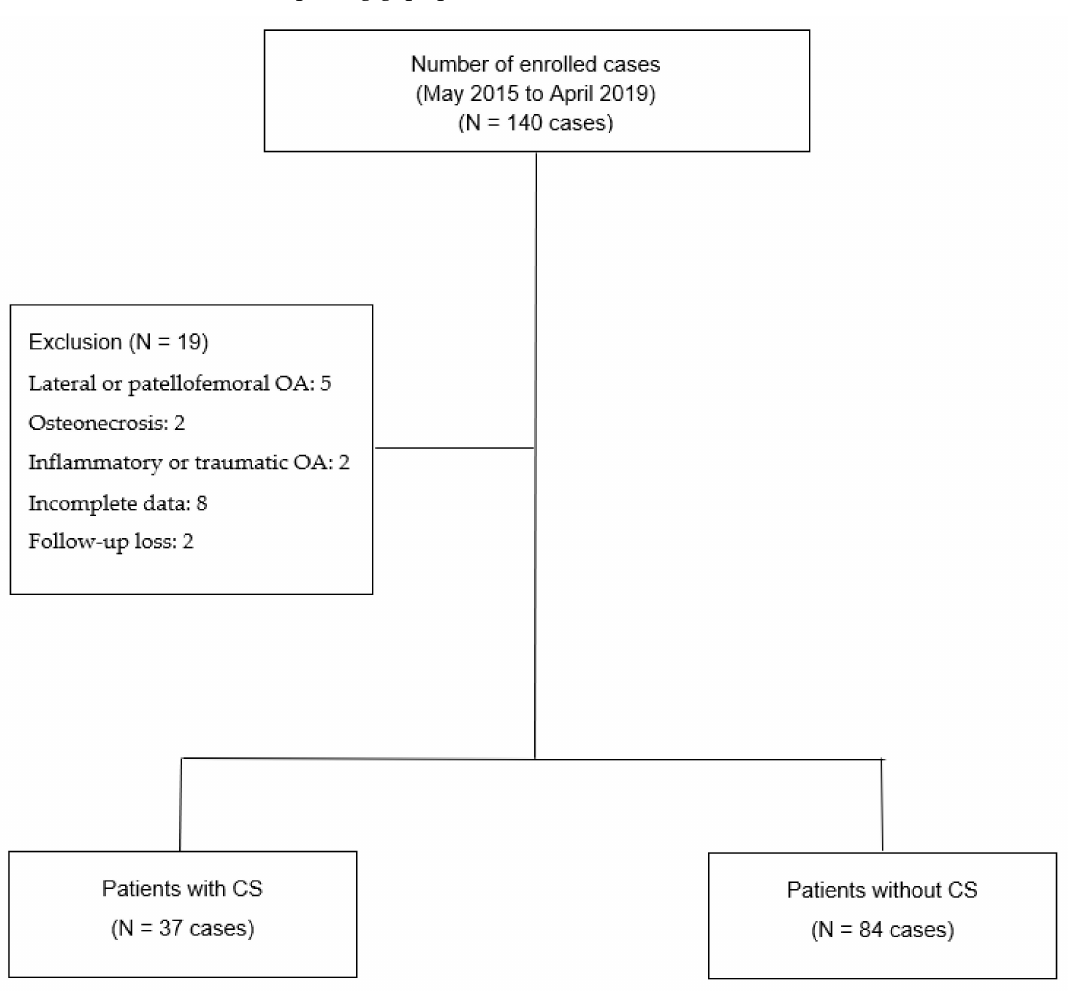
Figure 1. Patient